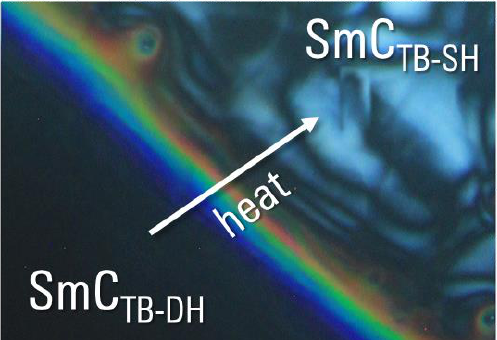
Figure 22. The optical texture shown by CB6O.12 taken in a 3 μm thick cell with homeotropic anchoring at the SmC TB-DH –SmC TB-SH transition showing selective reflection. The colours appear simultaneously because of a small temperature gradient in the sample. (Taken from [91]).